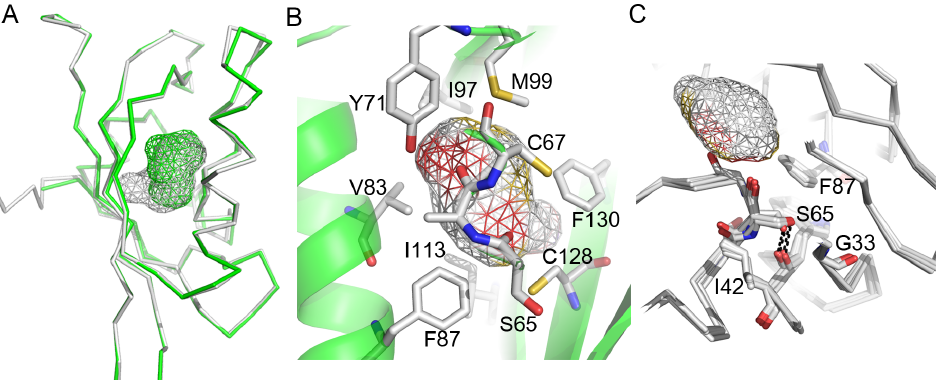
Figure 4. Cavities in the PAS domain from the mEAG channel. a) C a representations of two of the models (in green and gray) generated by combinations of side-chain conformers present in the asymmetric unit molecules of the mEAG PAS domain crystal. The cavities shown in gray and green wireframe correspond to the largest and smallest cavities, respectively, detected by CASTp server. b) Residues lining the largest cavity are shown as stick and are labeled. Cavity represented as wireframe. Colors on wireframe correspond to atoms lining the cavity: red for oxygens, yellow for sulfurs, white for carbons. The face of the cavity away from the reader is apolar and only colored white. c) Superposition of the 4 molecules in the asymmetric unit of mEAG PAS domain crystal. Serine in the hydrophobic core (S65) and surrounding residues are shown in stick, cavity is shown